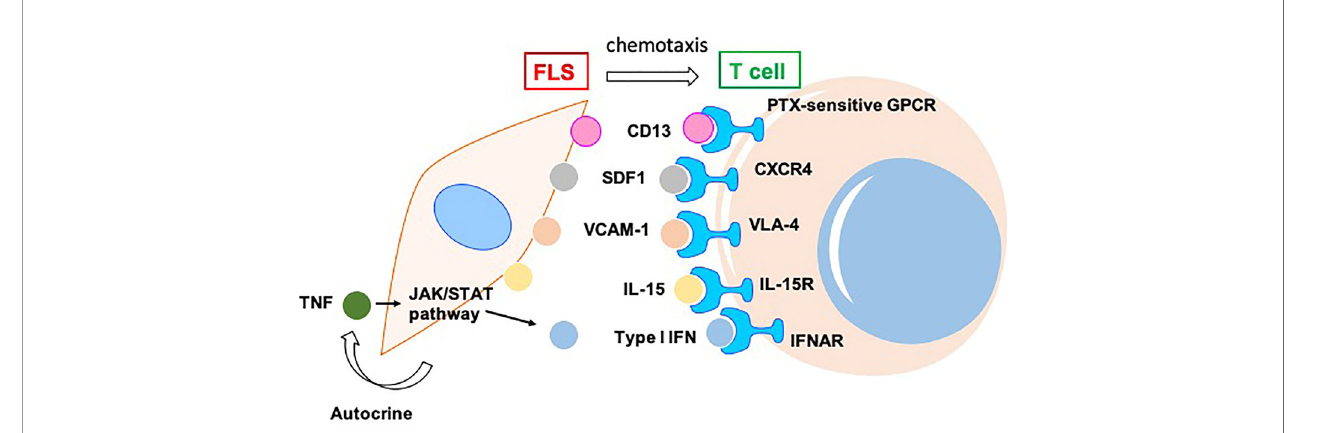
FIGURE 1 | RA-FLS indirectly promotes survival and chemotaxis of T cells in joint synovium of patients with RA via by producing various chemokines, including CD13, SDF1, VCAM1, IL15, TNF, and type I IFN. SDF, Stromal cell-derived factor; VCAM, Vascular cell adhesion molecule; VLA,Integrins alpha; CXCR, CXC motif chemokine receptor; IL, interleukin; JAK, Janus kinase; STAT, signal transducer and activator of transcription; TNF, tumor necrosis factor; IFN,